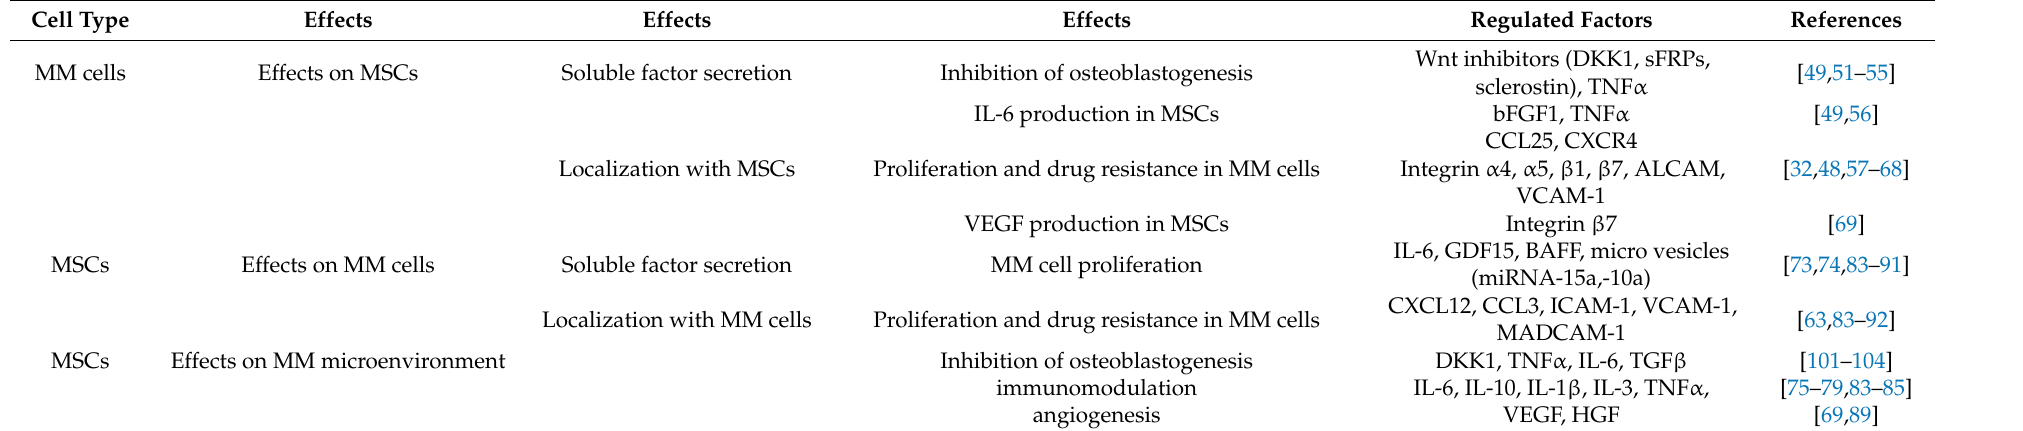
Table 1. Interaction between multiple myeloma cells and mesenchymal stromal